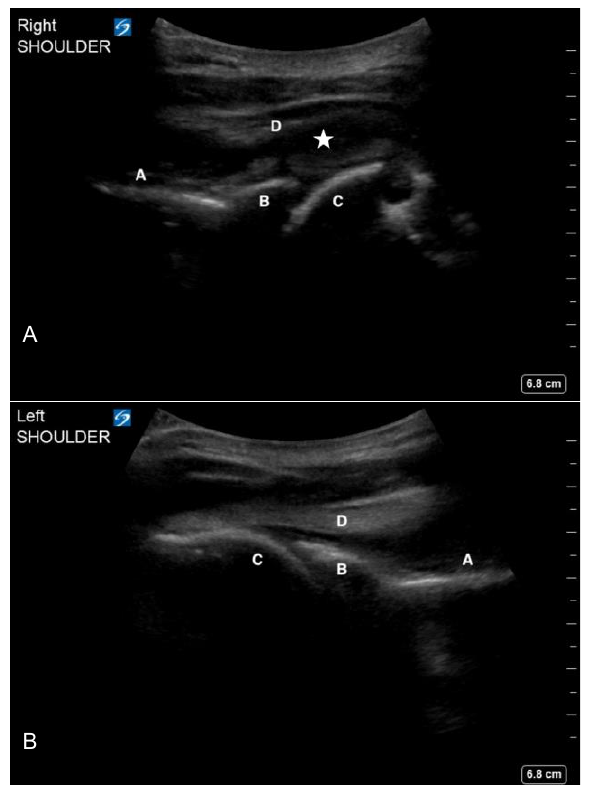
Image 2. Ultrasound images of the affected right shoulder (2A) and unaffected left shoulder (2B) showing scapular spine (A), glenoid (B), humeral head (C) and infraspinatus tendon (D). A mixed-echotexture collection consistent with an intraarticular hemarthrosis (star) is visualized in the right